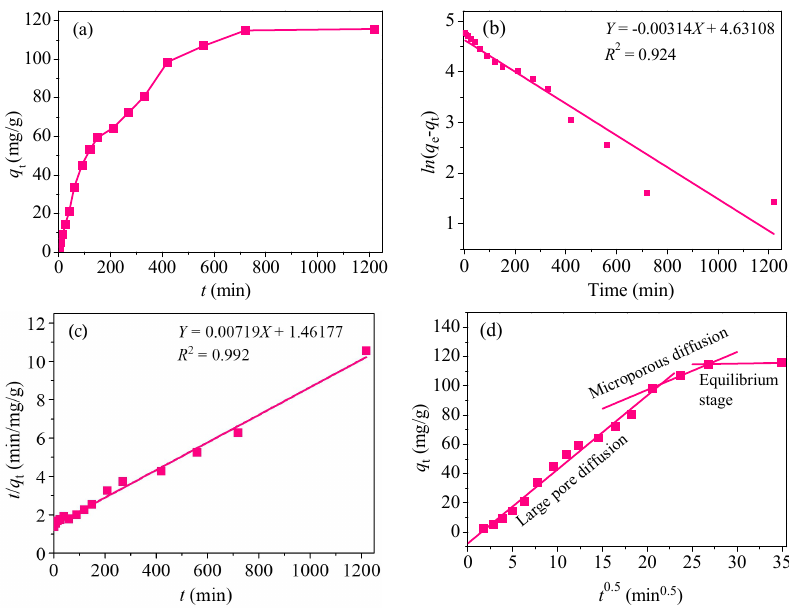
Figure 12. ( a ) Effect of time on the removal of Hg(II); ( b ) kinetic fittings of pseudo-first-order; ( c ) pseudo-second-order; ( d ) and intra-particle diffusion.